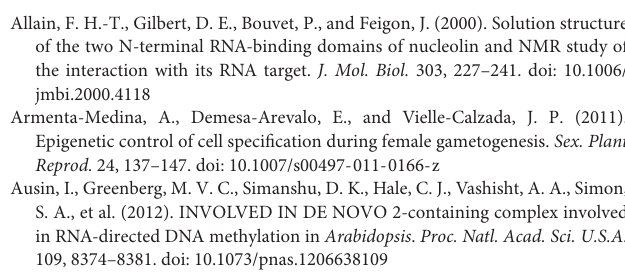
TABLE S2 | Summary of mRNA-seq data. For each library, the total number of reads as well as the number of mapped and unmapped reads are reported. TABLE S3 | Transcripts displaying differential expression in H. perforatum ovules (Bonferroni p -value correction). For each locus ID, transcript variants displaying no significant expression differences between sexual and aposporous samples are also reported. For each transcript, the locus ID in our reference genome, the alignment start/end and the number of allele variants are also reported. repBD: annotations regarding reproductive processes (Galla et al., 2017). GOrep: ontological annotations related to reproductive processes. Gene annotations were downloaded from AmiGO2 (http://amigo.geneontology.org/amigo). Epigenetic mod: annotations related to genes involved in epidenetic regulation of gene expression as reported by Pikaard and Mittelsten Scheid (2014). The average expression of each transcript in sexual (sexual – means) and aposporous (aposporous – means), together with Bonferroni and FDM p -values corrections associated to GE analyses are also reported. TABLE S4 | Transcripts annotated as phenotype-specific. Phenotype-specific transcripts were defined as transcripts expressed in all samples of a given phenotype and absent in all samples of the opposite phenotype. For each locus ID, transcript variants displaying no significant expression differences between sexual and aposporous sample as are also reported. For each transcript, the locus ID in our reference genome, the alignment start/end and the number of allele variants are also reported. repBD: annotations regarding reproductive processes (Galla et al., 2017). GOrep: ontological annotations related to reproductive processes. Gene annotations were downloaded from AmiGO2 (http://amigo.geneontology.org/amigo). Epigenetic mod: annotations related to genes involved in epigenetic regulation of gene expression as reported by Pikaard and Mittelsten Scheid (2014). The average expression of each transcript in sexual (sexual – means) and aposporous (aposporous – means), together with Bonferroni and FDM p -values corrections associated to GE analyses are also reported. TABLE S5 | Annotation and expression of genes located into the HAPPY (Hypericum APOSPORY) locus. For each contig ID and annotated locus, the table reports on the gene name, gene coordinates (locus start|end) and the ID of associated transcript variants. Genes annotated in the BAC clone HM061166 are indicated by using the bac ID followed by the gene name and percentage sequence identity with the aligned portion of the corresponding contig. Percent sequence identity is reported in bracket. For each transcript ID, the length of the alignment, the identity in the aligned portion of the sequence are indicated. The average expression of each transcript in sexual (sexual – means) and aposporous (aposporous – means), together with Bonferroni and FDM p -values corrections associated to GE analyses are also reported. TABLE S6 | GO Enrichment analysis. For each cluster of DEGs the over/under represented GO term (GO-ID), the ontological vocabulary (Ontology), the description of the GO term, the FDR corrected p -value and the p -value are reported. The number of annotated and non-annotated sequences in each test and reference datasets is also indicated. TABLE S7 | Annotation and expression of reproductive-related DEGs in ovules collected from sexual and aposporous accessions. For each locus ID, transcript variants displaying no significant expression differences between sexual and aposporous samples are also reported. For each transcript, the locus ID in our reference genome, the alignment start/end and the number of allele variants are also reported. repBD: annotations regarding reproductive processes (Galla et al.,